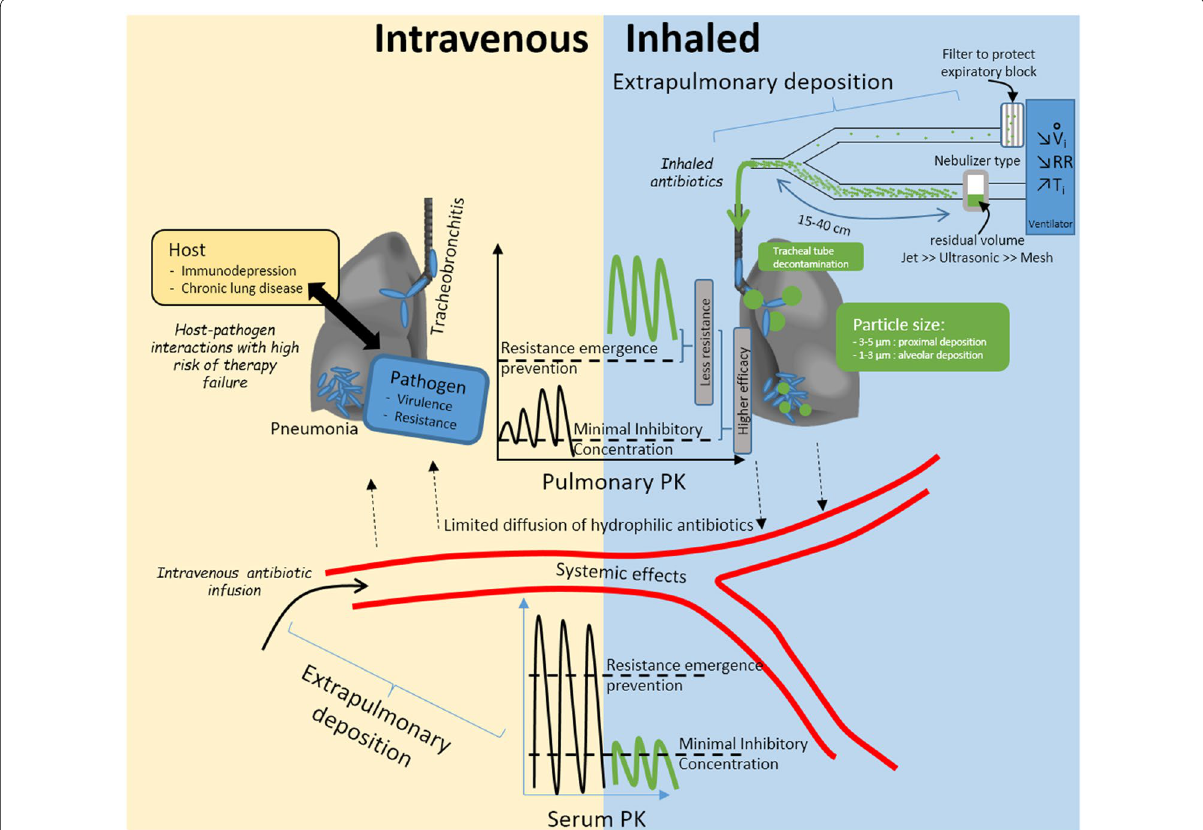
Fig. 2 Differences between intravenous and nebulized antibiotic therapy. Intravenous infusion ( yellow panel , left bottom corner ) leads to high extrapulmonary concentrations and potential toxicities. Diffusion to the lung is limited and resulting concentrations that may not exceed minimal inhibitory concentration can lead to treatment failure in challenging host–pathogen combinations. Nebulized delivery ( blue panel , right top corner ), implementing an optimized technique (detailed in Table 3) results in higher pulmonary concentrations that are above the resistance emergence prevention threshold, thus reducing the likelihood of resistant strain selection. These concentrations are well above the minimal inhibitory concen- tration, thus resulting in improved efficacy of concentration-dependent antibiotics, even with difficult-to-treat pathogens; systemic side effects may be reduced. Nebulization requires carful implementation so as to avoid potential respiratory side effects. PK pharmacokinetics, V i inspiratory flow, RR respiratory rate,